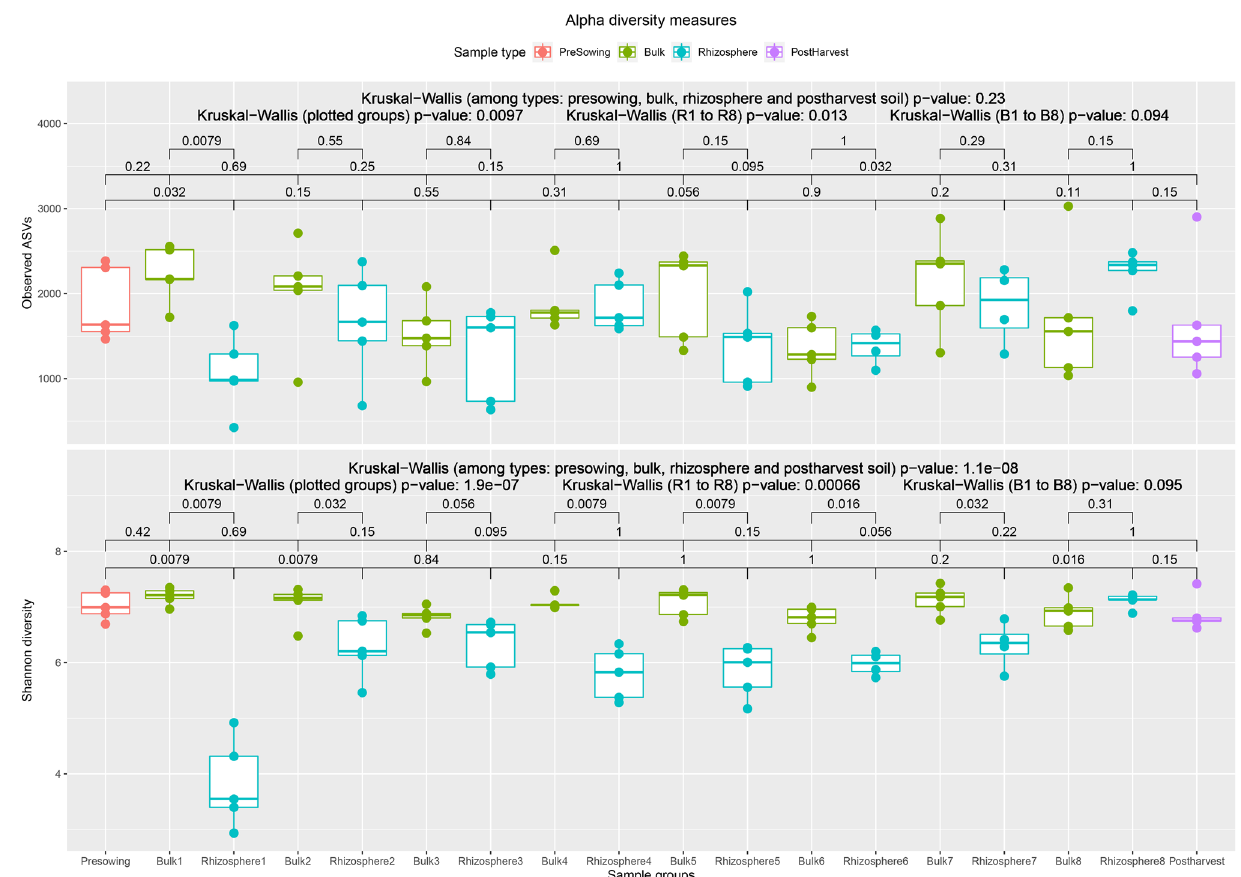
Figure 1. Alpha diversity measures Observed ASVs (top), and Shannon Index (bottom) plotted against sample groups. p-value from Wilcoxon-test between groups are given by bracket pointing to groups. p-value from Kruskal–Wallis test among four types/groups of samples is mentioned on the top. Second line mentions p-value from Kruskal–Wallis test of all groups (as plotted), all rhizosphere sample groups/collections and bulk soil sample